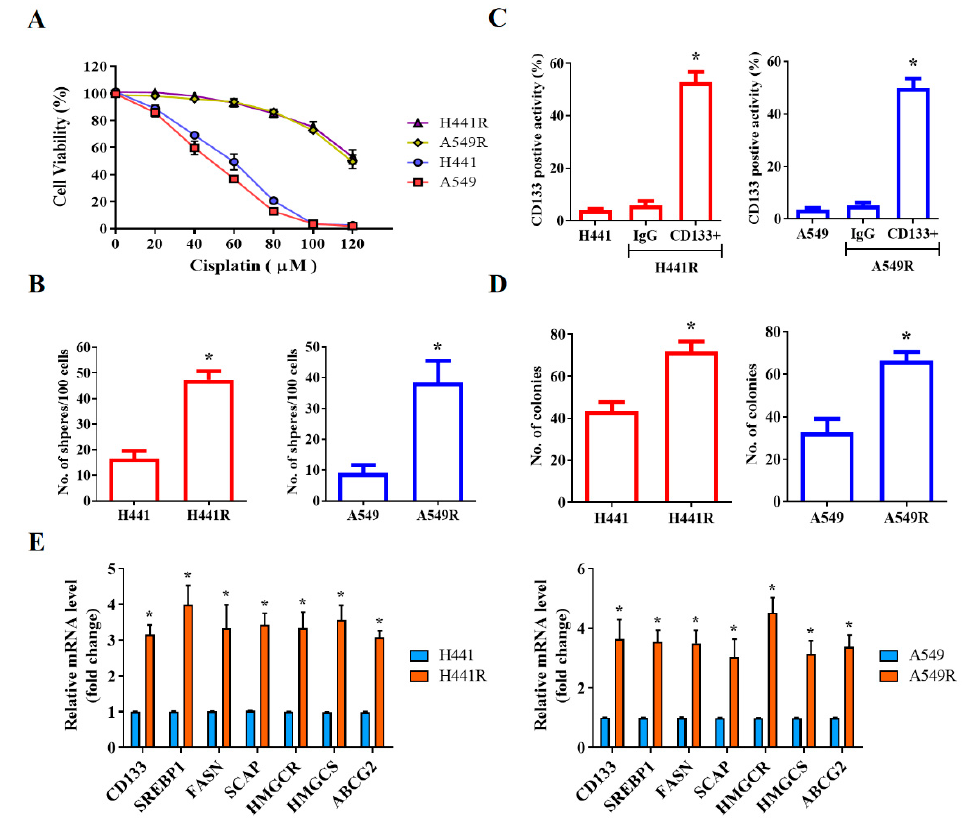
Figure 2. SCAP/SREBP lipogenic signaling axis is associated with cisplatin resistance and cancer stemness in NSCLC cells. ( A ) Comparative MTT assay demonstrating the effect of cisplatin on H441, H441R, A549, and A549R cells. ( B ) Representative flow cytometry images of the levels of CD133 in H441, H441R, A549, and A549R cells. Graphical representation of the number of ( C ) spheres and ( D ) colonies formed by H441, H441R, A549, and A549R cells. ( E ) Histograms indicating the compar- ative expression of CD133, SREBP-1, FASN, SCAP, HMGCR, HMGCS, and ABCG2 mRNA in H441, H441R, A549, and A549R cells. All data are represented as means ± SDs from assays performed in triplicate at least 3 times. * p < 0.05.